Question: Write a single sentence explaining what this figure depicts.
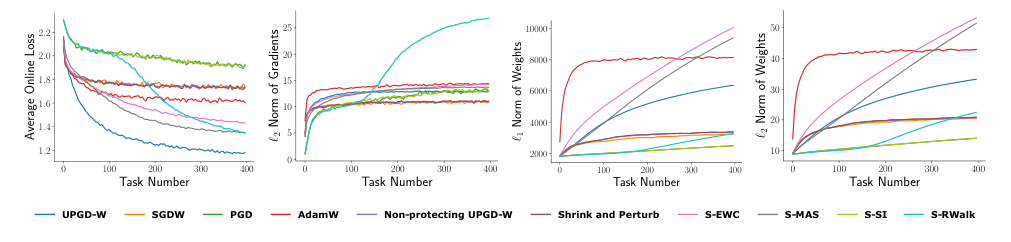
Answer: Diagnostic statistics of methods on Label-permuted CIFAR10. The average plasticity, percentage of zero activations, ℓ0, ℓ1 and ℓ2-norm of gradients, the average online loss, the ℓ1-norm and ℓ2-norm of the weights are shown. The shaded area represents the standard error.